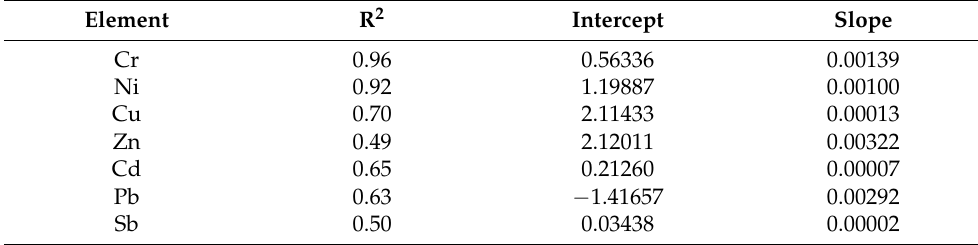
Table A4. Background functions of potentially toxic elements (PTEs) in the studied tufa samples used to calculate local enrichment factors (LEFs). The best fit was obtained using a least trimmed squares (LTS) regression as a robust statistical method. The natural concentrations of the target elements (Cr, Ni, Cu, Zn, Cd, Pb and Sb) were predicted by empirical functions of Al as the independent variable. Background concentrations (EBN) were predicted by the formula: [intercept + (slope × Al)]. LEFs were then calculated by dividing the concentrations of the PTEs by their predicted values (LEF = E/EBN). The elements are arranged following the periodic table